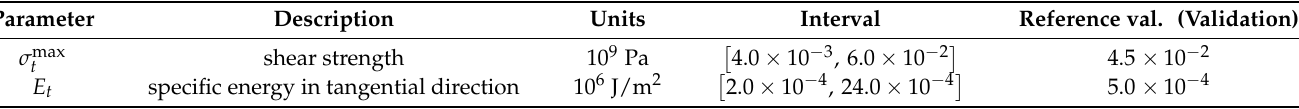
Table 2. Table with the parameter use for data assimilation, with their corresponding interval values, as well as a “reference value” for the validation of the assimilation algorithm. The parameters are sampled using the LHS strategy, where each parameter is assumed to have a uniform distribution. The intervals for each parameter are derived in an ad hoc manner from previous HOSS simulations for granite